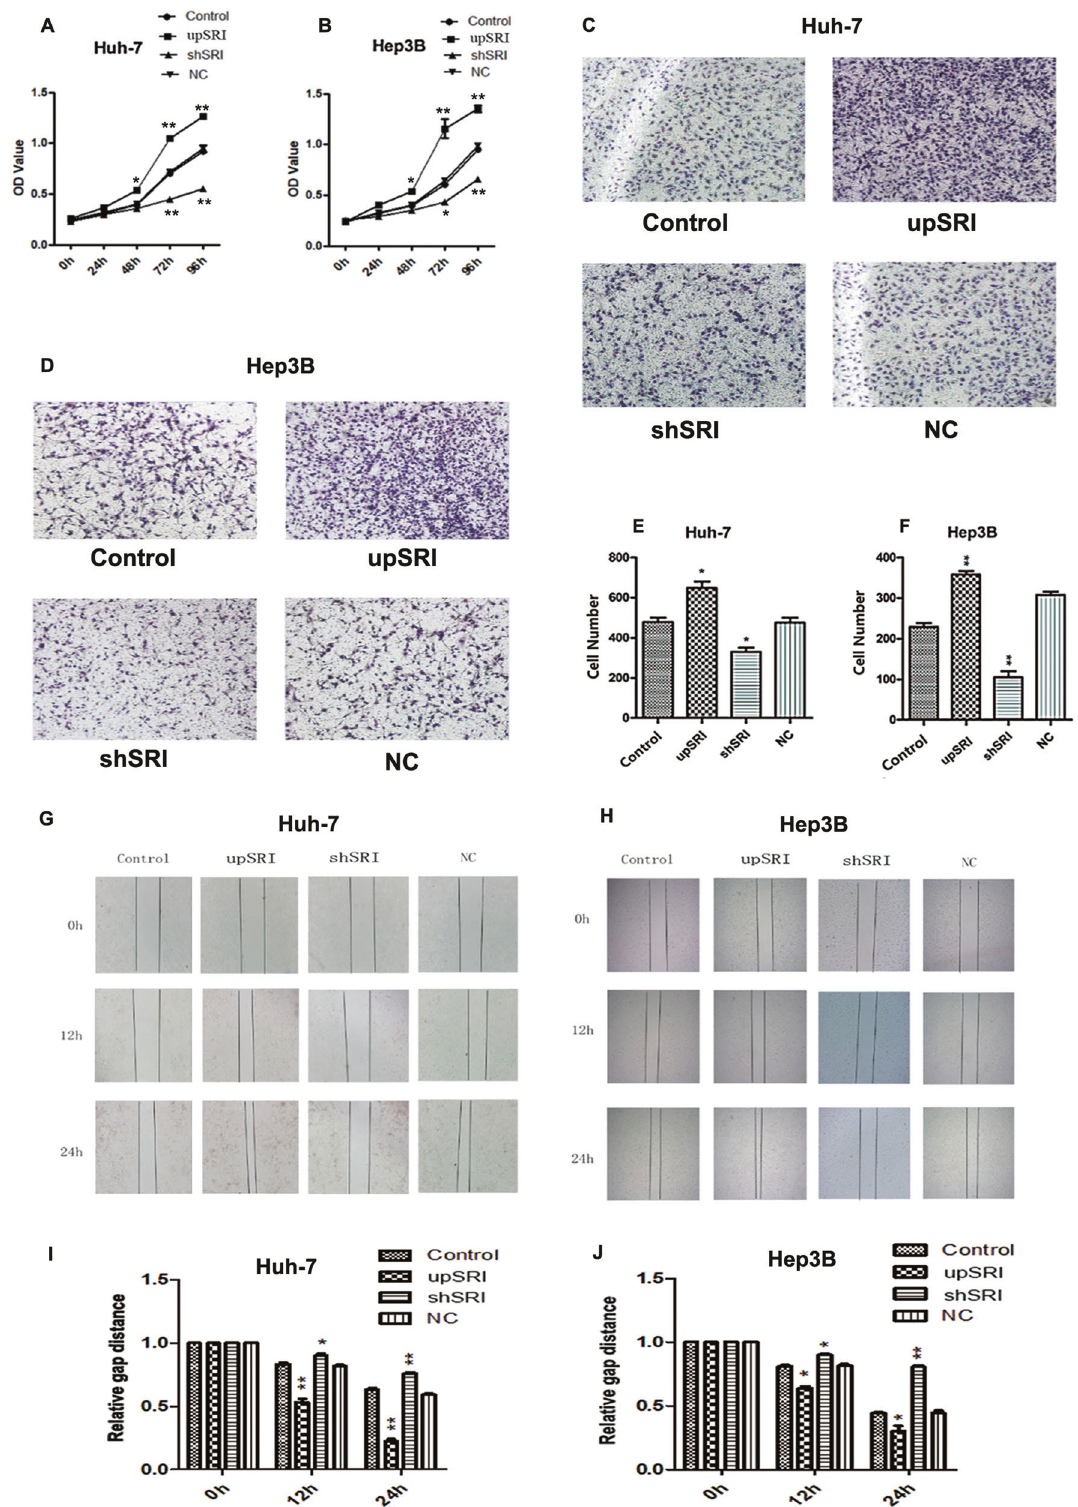
Fig. 7 SRI dysregulation affects the invasion, proliferation, and migration of HCC cells. A , B CCK8 assay showed that SRI upregulation promoted proliferation, whereas SRI downregulation suppressed proliferation of Huh-7/Hep3B cells (* p < 0.05). C – F Transwell invasion assays showed that SRI upregulation promoted invasion, whereas SRI downregulation inhibited invasion of Huh-7/Hep3B cells (** p < 0.01,* p < 0.05). G – J Representative images of migration assays of Huh-7 and Hep3B cells showed SRI upregulation promoted the migration, otherwise, SRI downregulation inhibited its migration at 0 h,12 h, and 24 h (** p < 0.01, * p < 0.05).